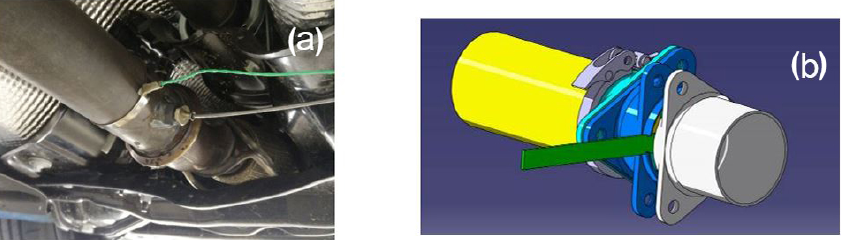
Figure 4. (a) Exhaust system of a Ford Focus RS Mk III with two mounted type K reference thermocouples and (b) mounting system for different thick-film thermocouple sensor layouts on planar and tubular